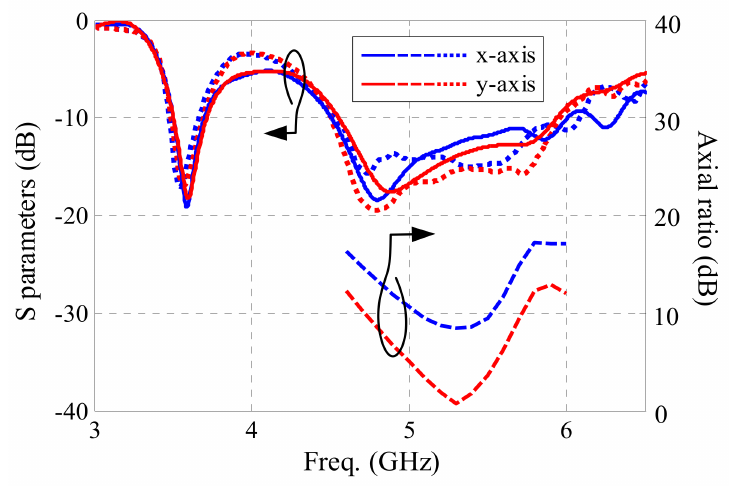
Figure 16. Antenna sensor performance under bending. The blue lines indicate the bending case along x -axis. The red lines indicate the bending case along y -axis. The solid lines indicate the measurement results. The dashed and dotted lines indicate the simulation results.